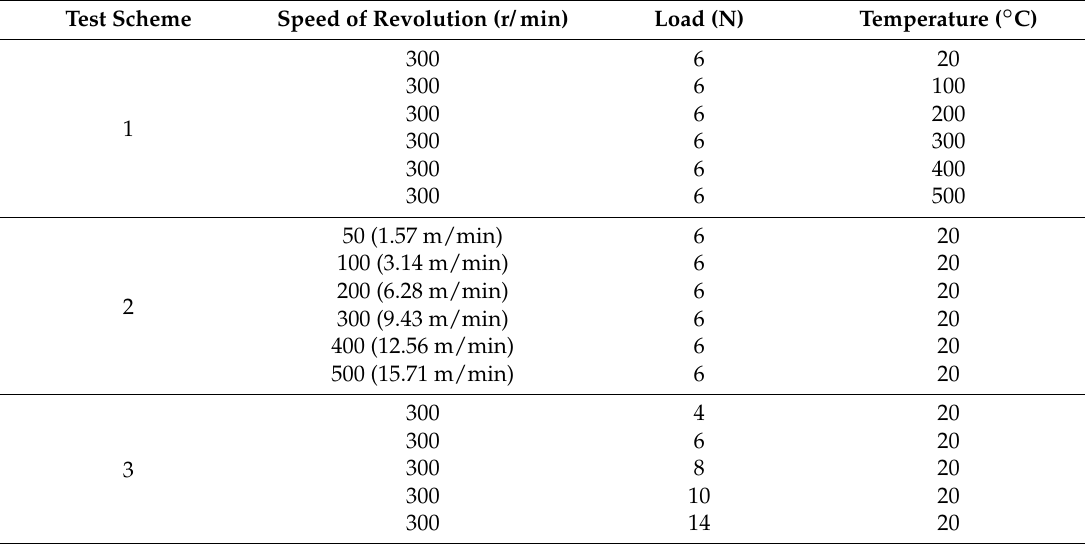
Table 5. Schemes of tests.